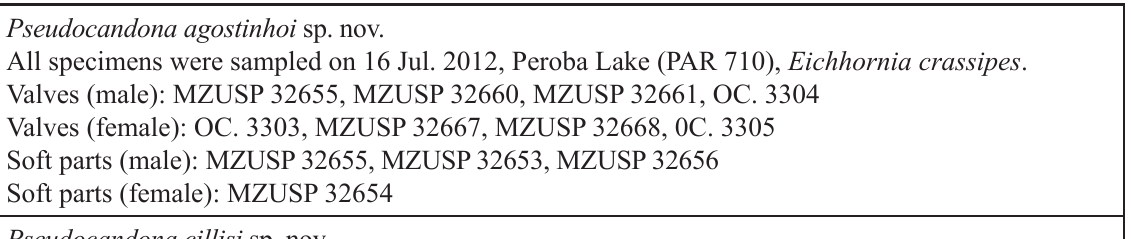
Table 2. Locality data of specimens used for illustrations in the present Pseudocandona agostinhoi sp. nov.